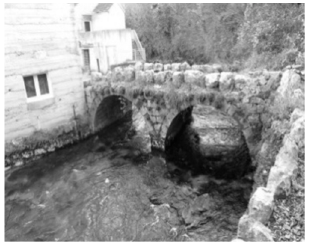
Figure 9. Small bridge over river Grab, Grab (B6).